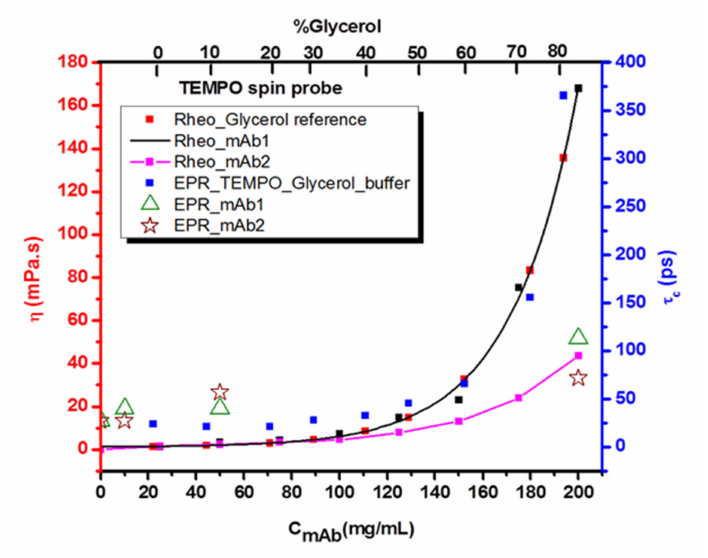
Figure 6. Correlation plot between dynamic viscosities ( η ) and rotational correlation times ( τ c ) as a function of mAb concentration (lower x-axis) and glycerol content (given in %, upper x-axis) for TEMPO-mAb (green and red symbols) and TEMPO–Glycerol and glycerol as reference (in blue and black squares)